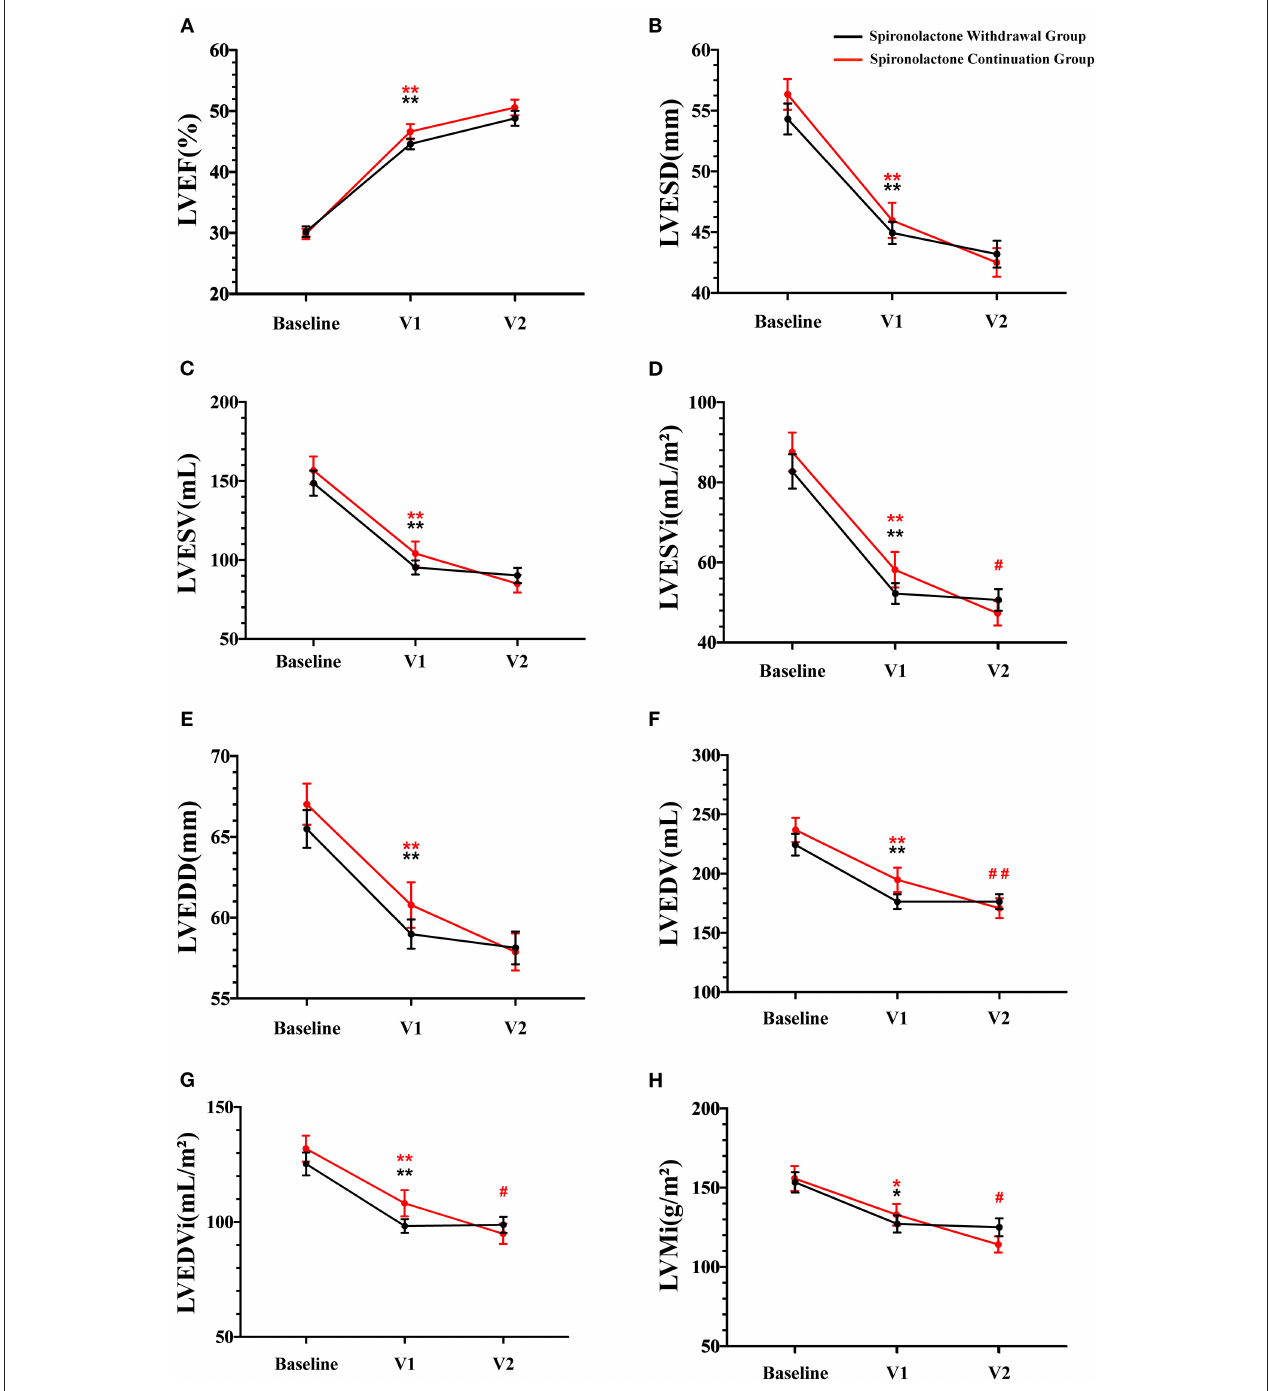
FIGURE 4 | Echocardiographic parameters during follow-up. V1 represented the time when LVEF improved; V2 represented the final 1-year outcome analysis visit; LVEF, left ventricular ejection fraction; LVESD, left ventricular end-systolic diameter; LVESV, left ventricular end-systolic volume; LVESVi, LVESV indexed by body surface area; LVEDD, left ventricular end-diastolic diameter; LVEDV, left ventricular end-diastolic volume; LVEDVi, LVEDV indexed by body surface area; LVMi, left ventricular mass indexed by body surface area. Data are represented as the mean ± SEM. * p < 0.05 and ** p < 0.01 compared to values at the time of first diagnosis; # p < 0.05 and ## p < 0.01 compared to values at the time of improved ejection fraction identified.